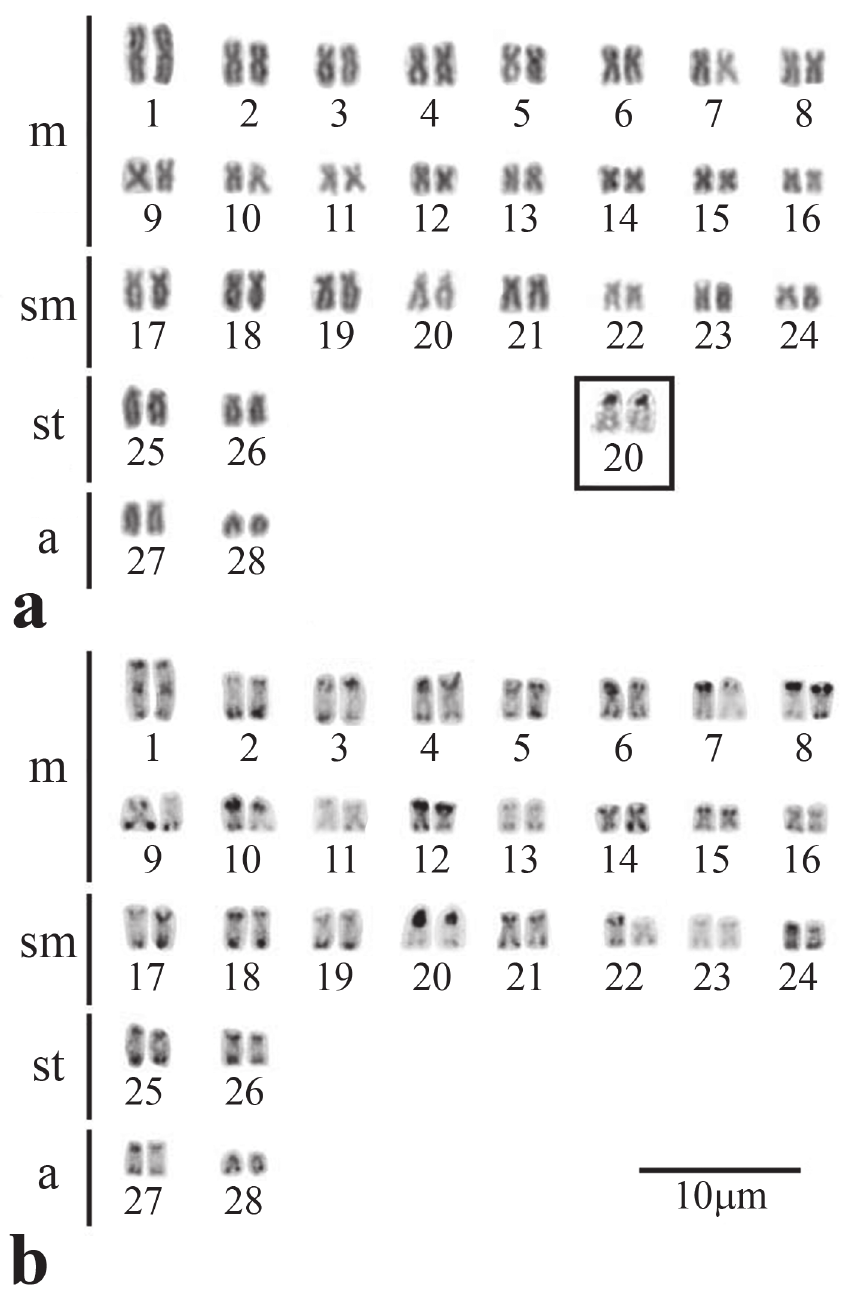
Fig. 1. Karyotypes of Ageneiosus inermis stained with Giemsa ( a ) and sequentially C-banded ( b ). The AgNORs bearing chromosomes pair is presented in